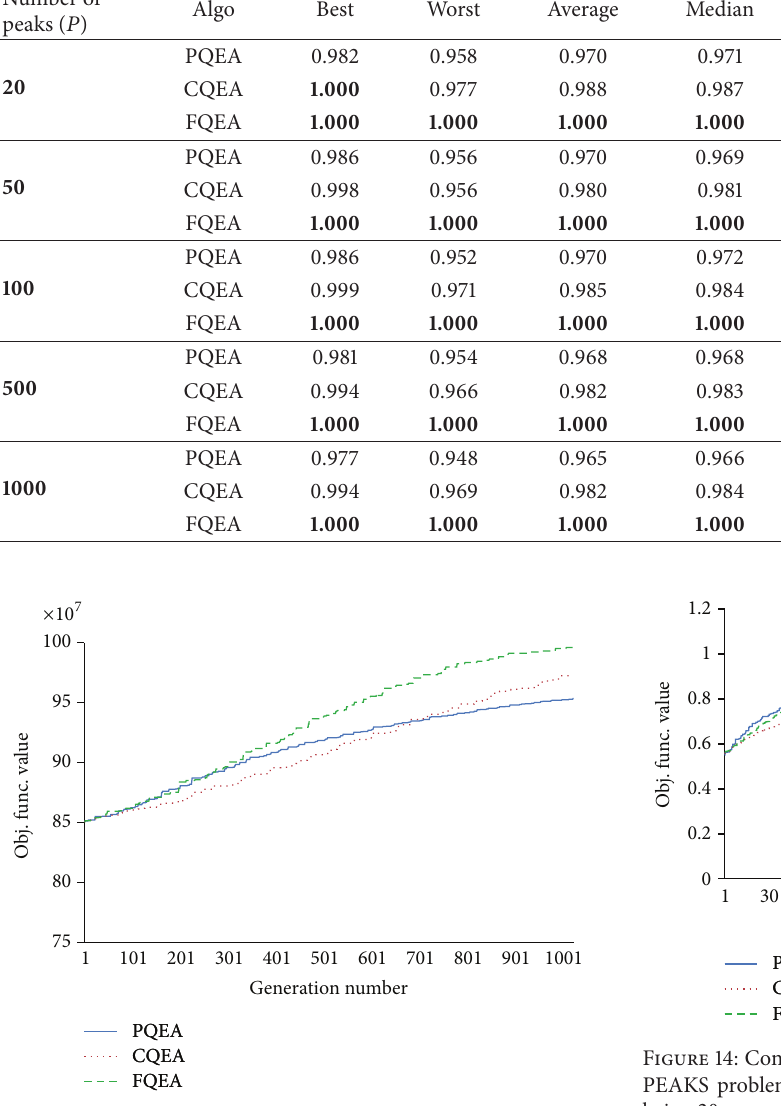
Figure 13: Convergence graph of PQEA, CQEA, and FQEA on COUNTSAT problem size, 𝑛 , being 1000.